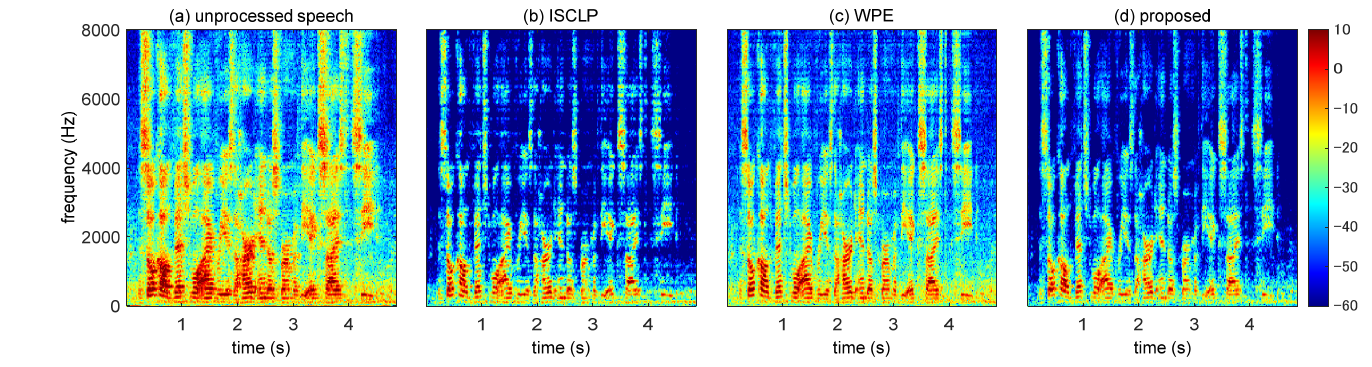
Figure 5. Spectrogram comparison in the case of SNR = 10 dB and T 60 = 800 ms.